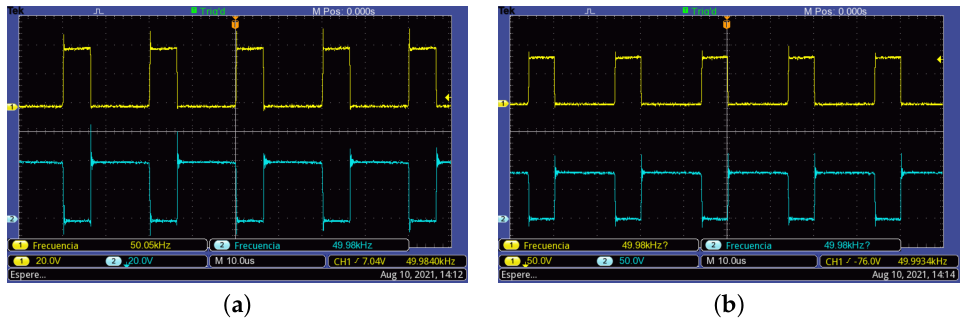
Figure 13. Switching device voltages. ( a ) Active switch S 1 ( Top ) and diode S 2 ( Bottom ). ( b ) Active switch S 3 ( Top ) and diode S 4 ( Bottom